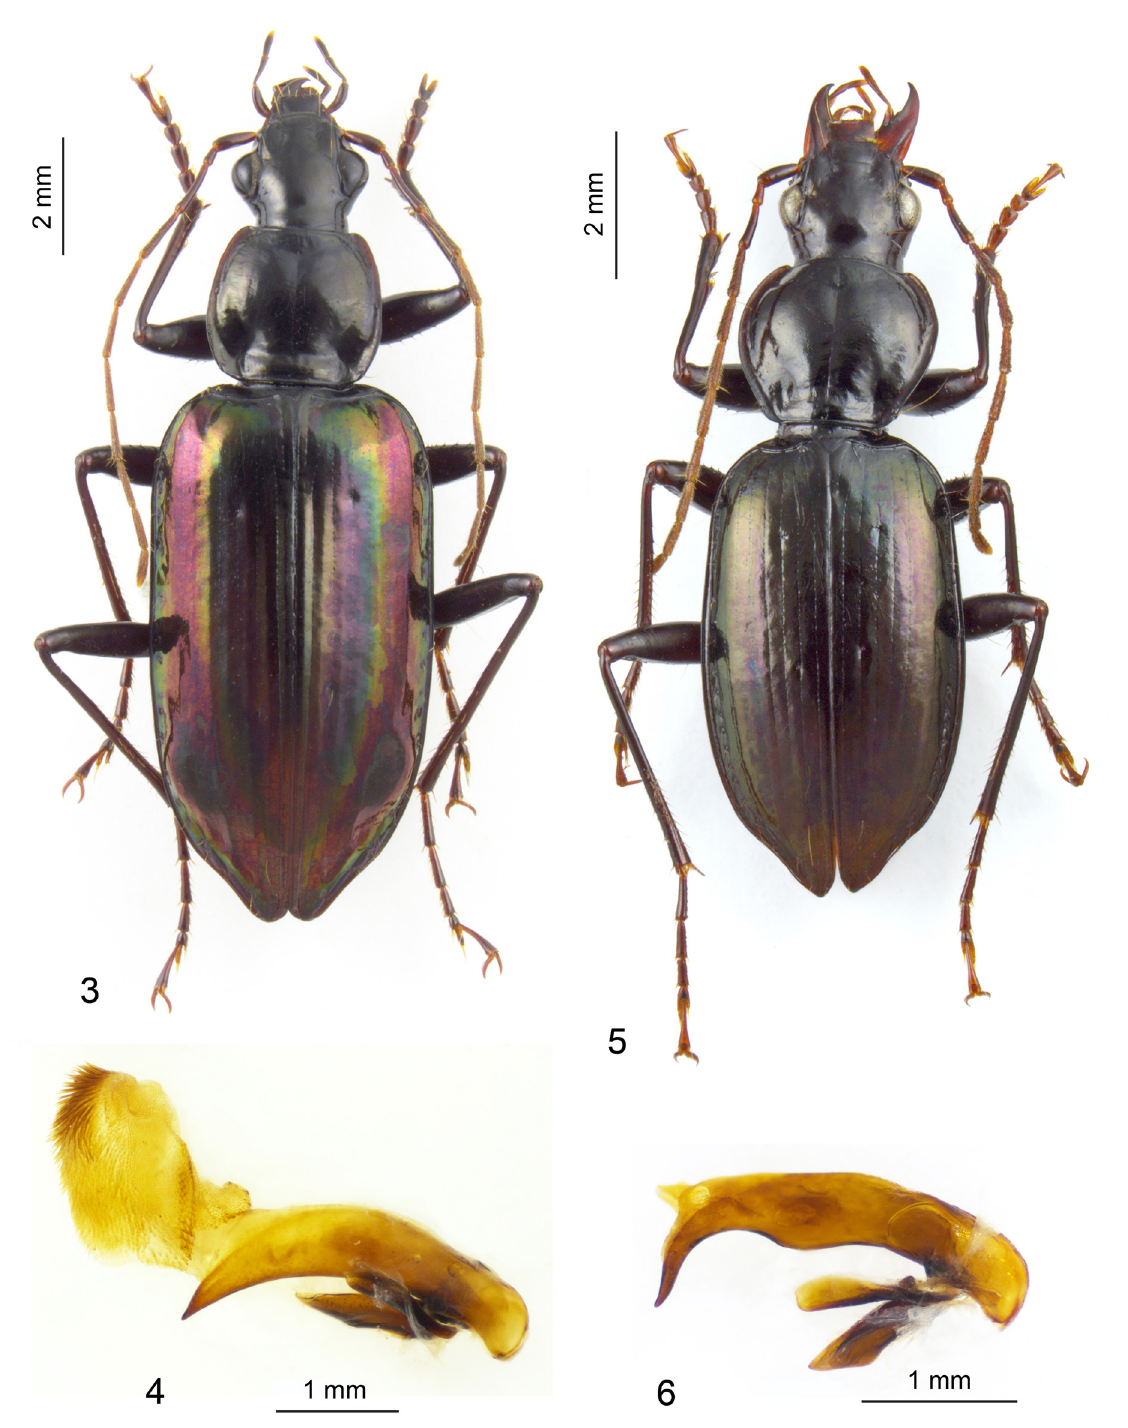
Figs 3–6. 3–4 . Dyscolus eleonorae Moret sp. nov. 3. Habitus of the male holotype (QCAZ). 4 . Aedeagus, median lobe in lateral view. 5–6 . D. giselae Moret sp. nov. 5 . Habitus of the male holotype (QCAZ). 6 . Aedeagus, median lobe in lateral